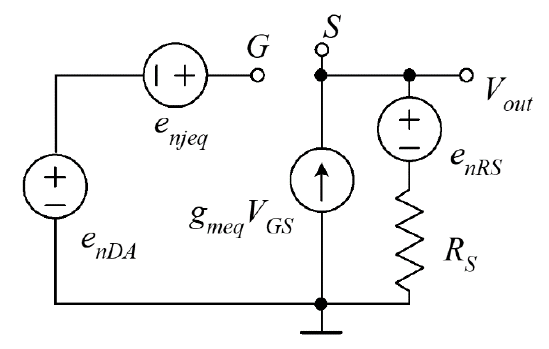
Figure 3. Equivalent circuit for noise calculation.